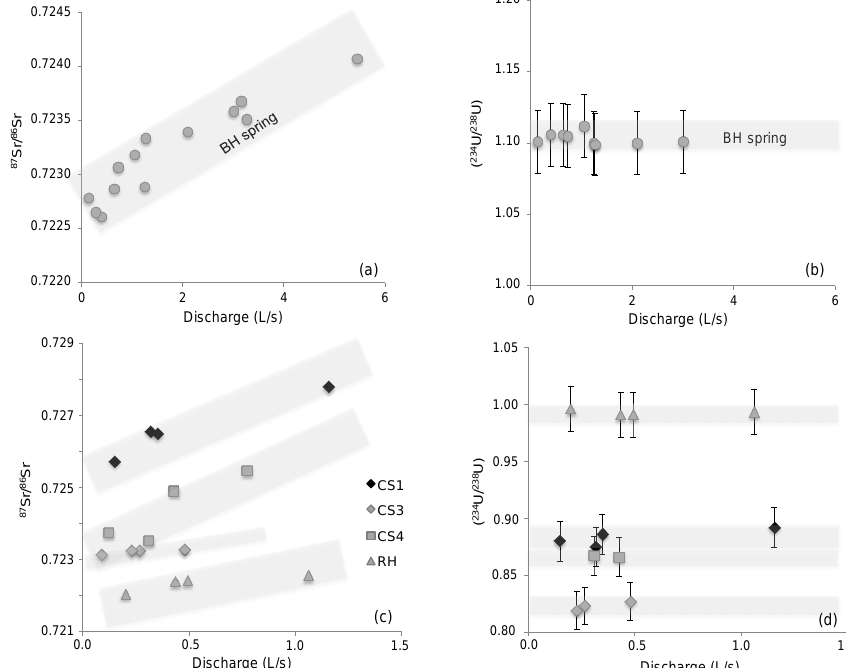
Figure 6. 87 Sr / 86 Sr and ( 234 U / 238 U) AR vs. discharge for the springs BH, CS1, CS3, CS4 and RH from the Strengbach watershed.